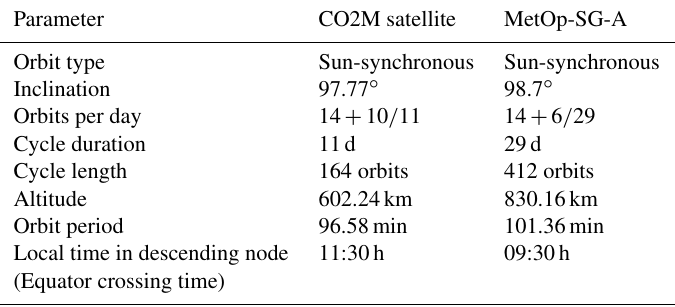
Table 2. Satellite platforms and their orbit parameters used in this study. Note that some parameters slightly deviate from the real satellites (see text for details).